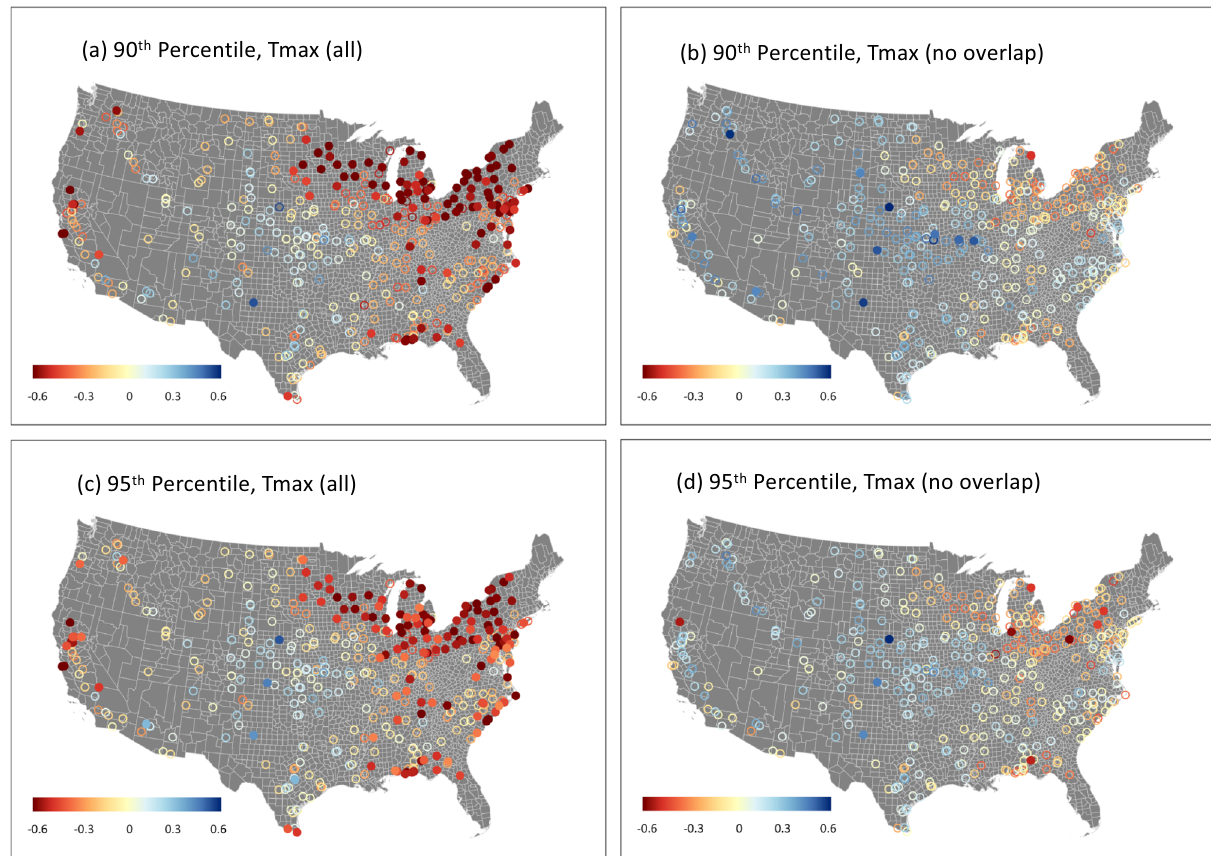
Figure 2. Correlation between dry and humid heat days for the corn growing regions. Year-to-year correlation coefficients for ( a , c ) between the number of extreme heat days (exceeding the 90th or 95th percentile threshold of maximum daily dry-bulb temperature, Tmax) and extreme humid heat days (exceeding the local 90th or 95th percentile thresholds of daily maximum daily wet-bult temperature, Twmax), and ( b , d ) between the number of extreme dry heat days (exceeding the 90th or 95th percentile threshold for Tmax, but not exceeding the corresponding threshold for Twmax) and extreme humid heat days. Correlation values significant at the 5% level using a two-sided Student-t test are shown as filled circles and the non-significant correlations are shown as open circles. The maps are made with ArcGIS Pro 2.2.0 with the US base map downloaded from Census